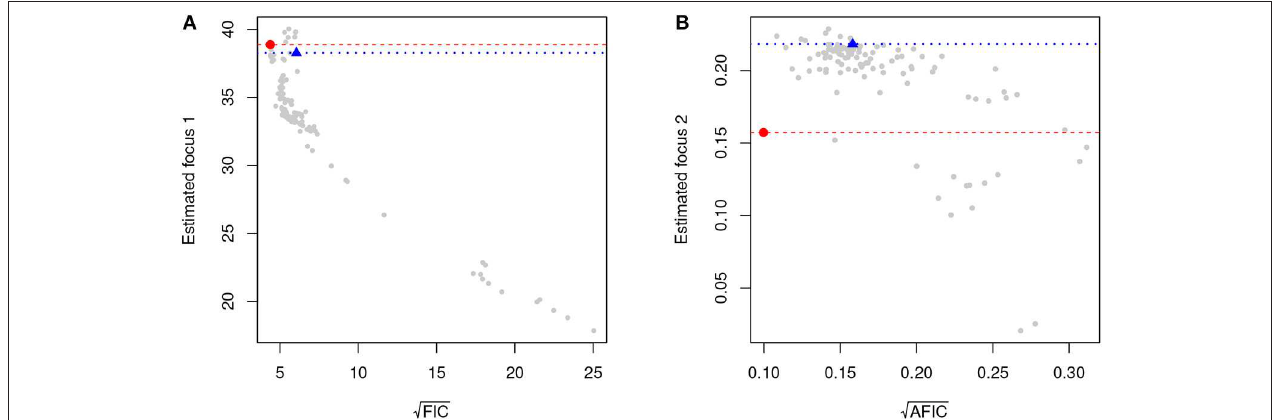
FIGURE 1 | The two plots give values for a total of 113 Poisson regression models, related to two different focused questions. (A) FIC plot for estimating the expected number of bird species for the Chiles region. (B) AFIC plot for estimating the probability of observing over 30 species, averaging over all 14 islands. The red dot and line indicate the selected value, the blue triangle and line are for the wide